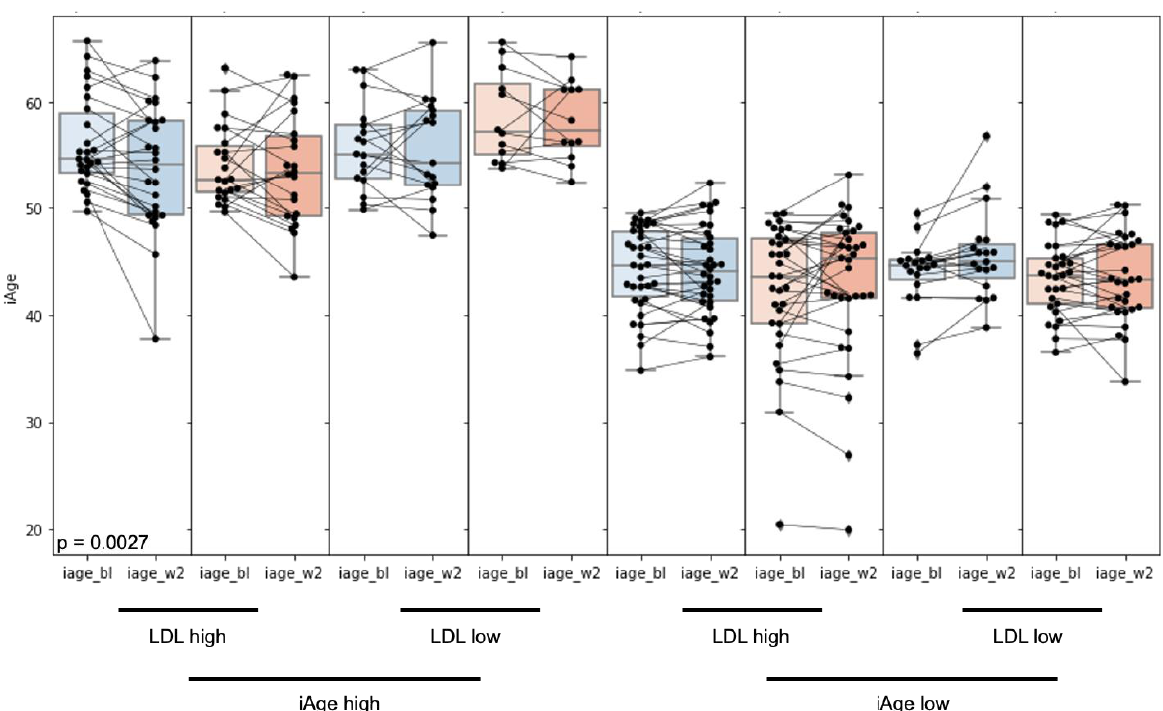
Figure 3. Effects of stratification by both baseline iAge ® and LDL levels on the change in iAge ® . The value for iAge ® (y-axes) is provided for each patient as a black dot, and the change in that value for each patient between baseline as week 2 (x-axes) is represented by a connecting black line. The statistics for each group are shown using box plots, and significance between baseline and week 2 was calculated using a pairwise two-tailed t -test. The oat product (blue) and placebo (red) treated groups were subset into high/low baseline iAge ® using a cutoff of 49.6 years and high/low baseline LDL levels using a cutoff of 3.27 mmol/L. The only significant change in iAge ® at week 2 was observed with the oat treated group that had both high baseline iAge ® and LDL levels. LDL, low-density lipoprotein.